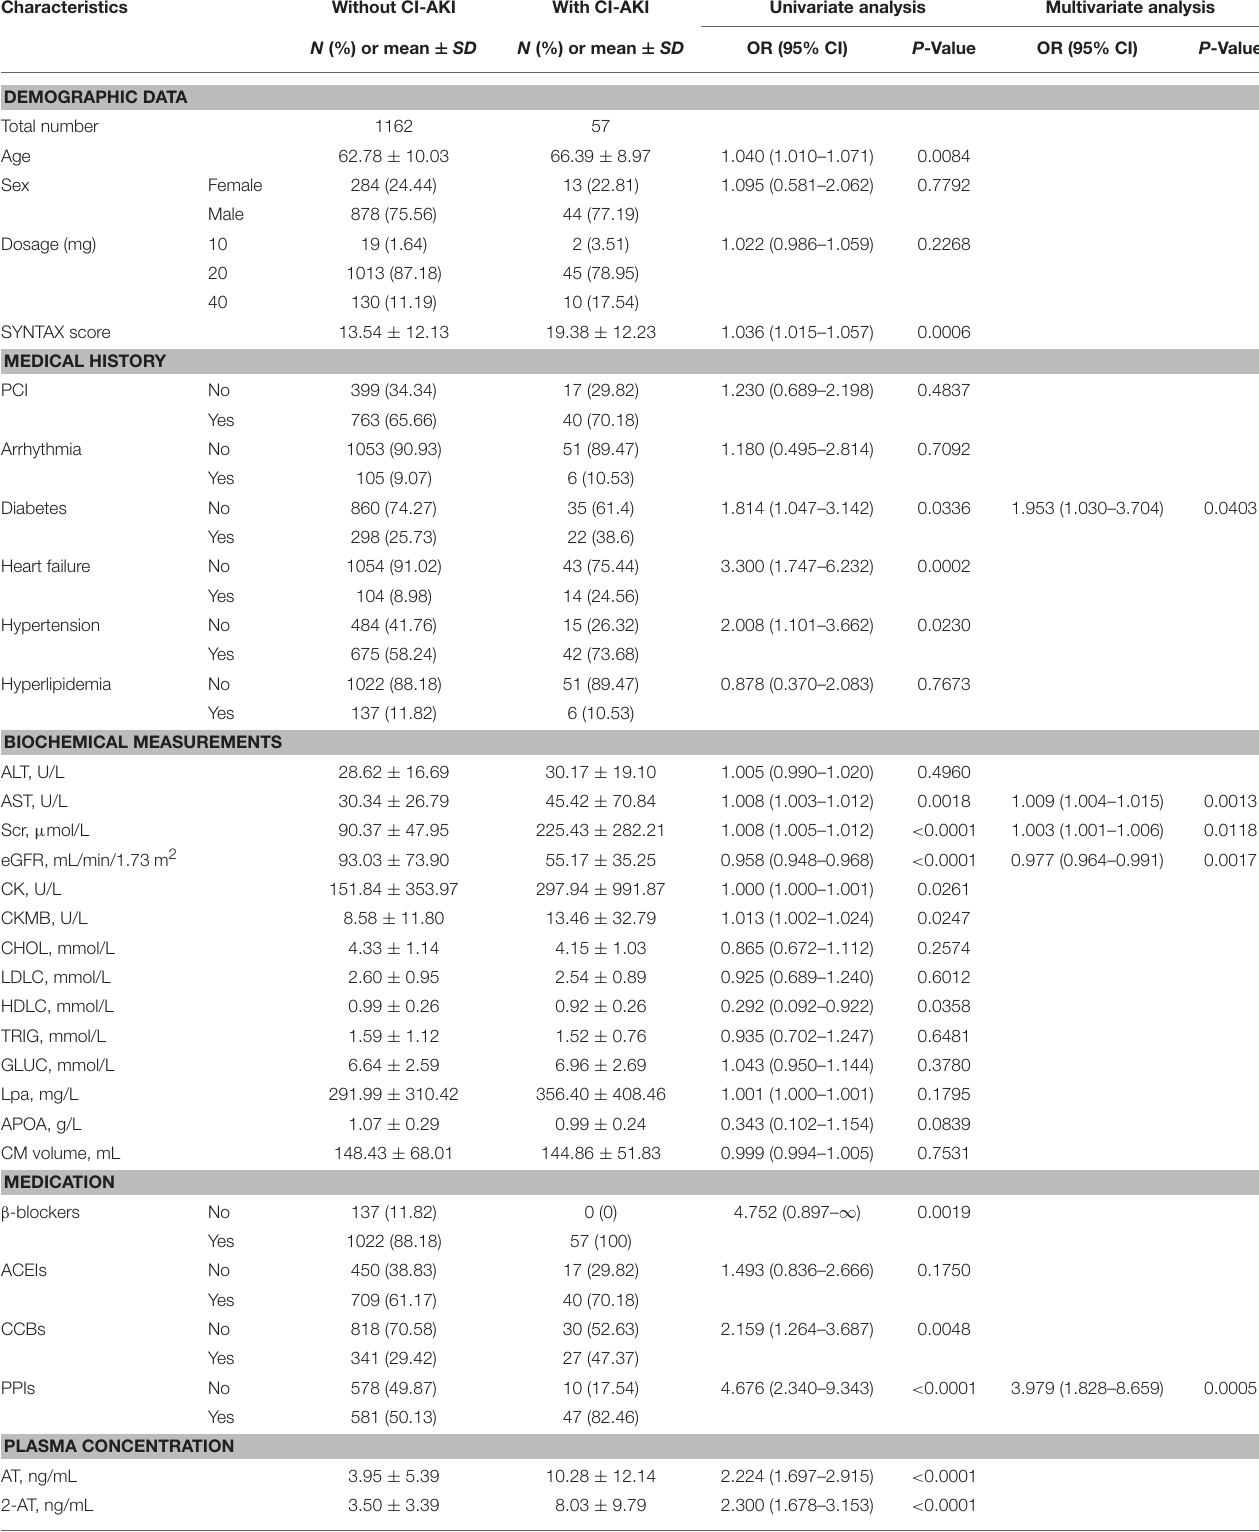
TABLE 3 | Effects of baseline characteristics and plasma concentrations of AT and its metabolites on CI-AKI in stage I. Characteristics Without CI-AKI With CI-AKI Univariate analysis Multivariate